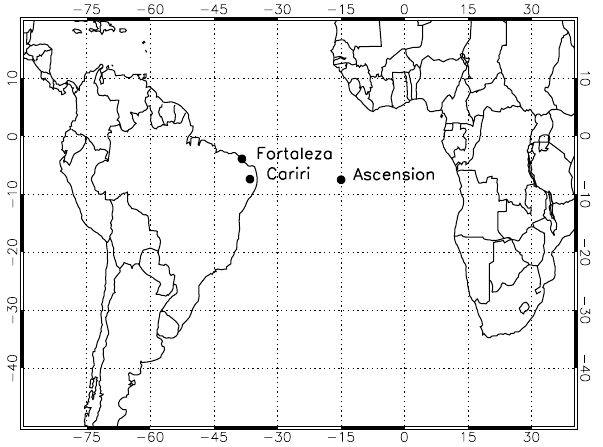
Fig. 1. Geographic locations of the observation sites.